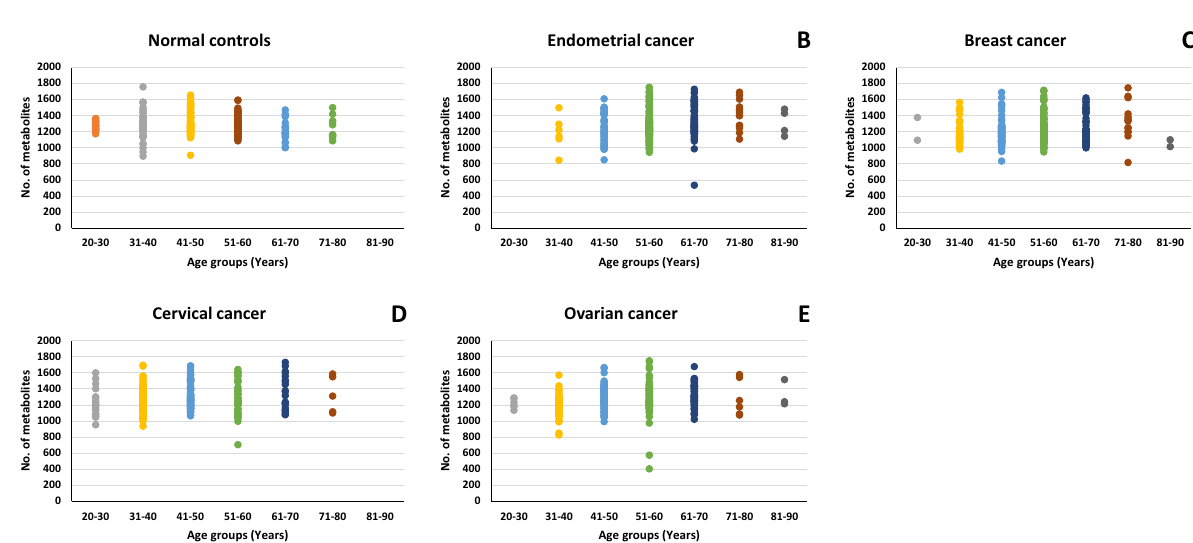
Figure 2. Age-wise detection of detected metabolites. Figure provides a graphical representation of the number of metabolites detected across the individual age groups, for the normal control set as well as the individual cancer groups. The cumulative unique metabolites detected in normal control samples were 5895. While, endometrial, breast, cervical and ovarian cancer samples were found to have 5971, 5982, 6300 and 6336